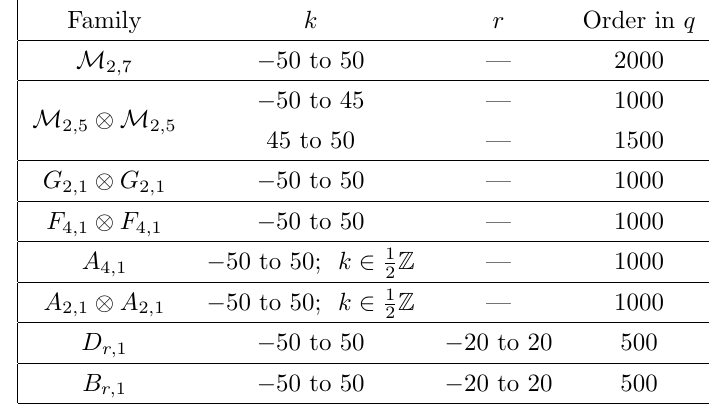
Table 4 . Range of veri(cid:12)cation of Quasi-character